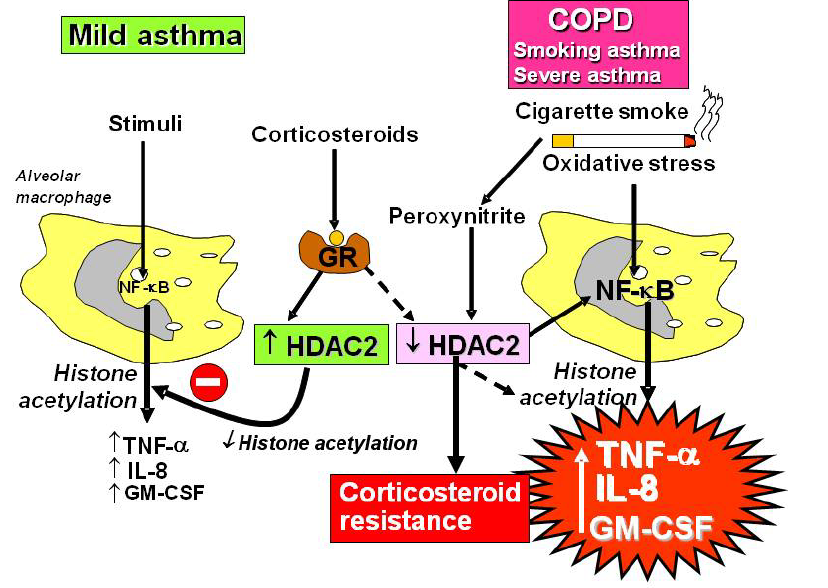
Figure 5. Mechanism of corticosteroid resistance in COPD, smoking asthma and severe asthma. Stimulation of mild asthmatic alveolar macrophages activates nuclear factor- κ